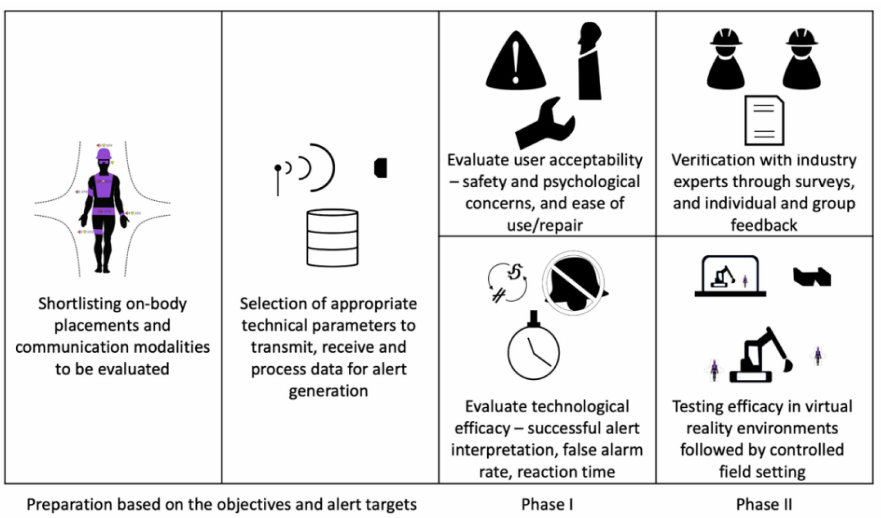
Figure 8. A preliminary two-phase framework to evaluate various on-body placements and commu- nication modalities for wearable safety promotion